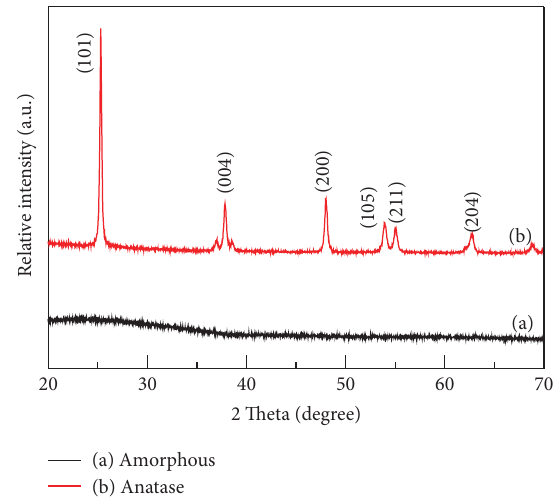
Figure 2: XRD patterns of TNT arrays before and after annealing.